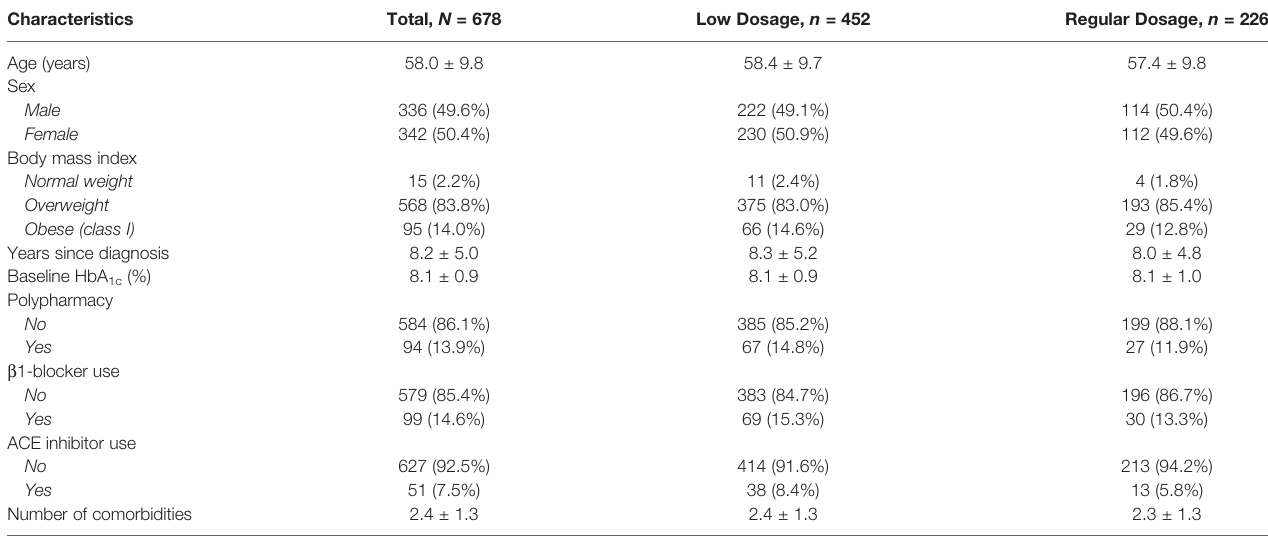
TABLE 2 | Baseline characteristics of the study population ( N = 678 participants).